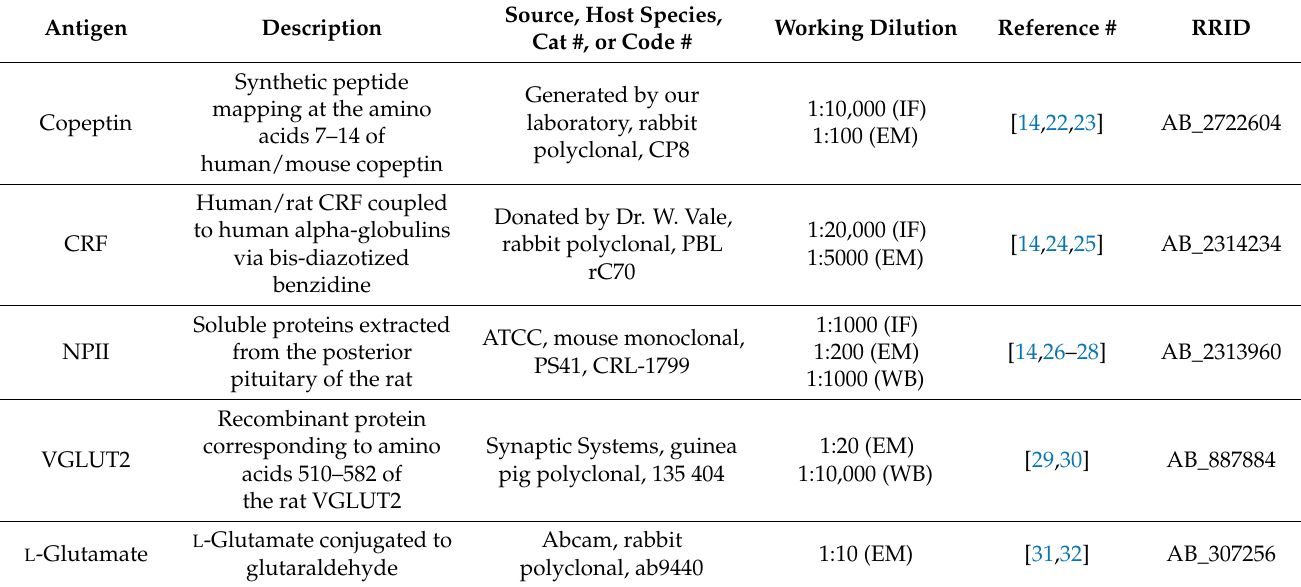
Table 1. Primary antibodies used in this